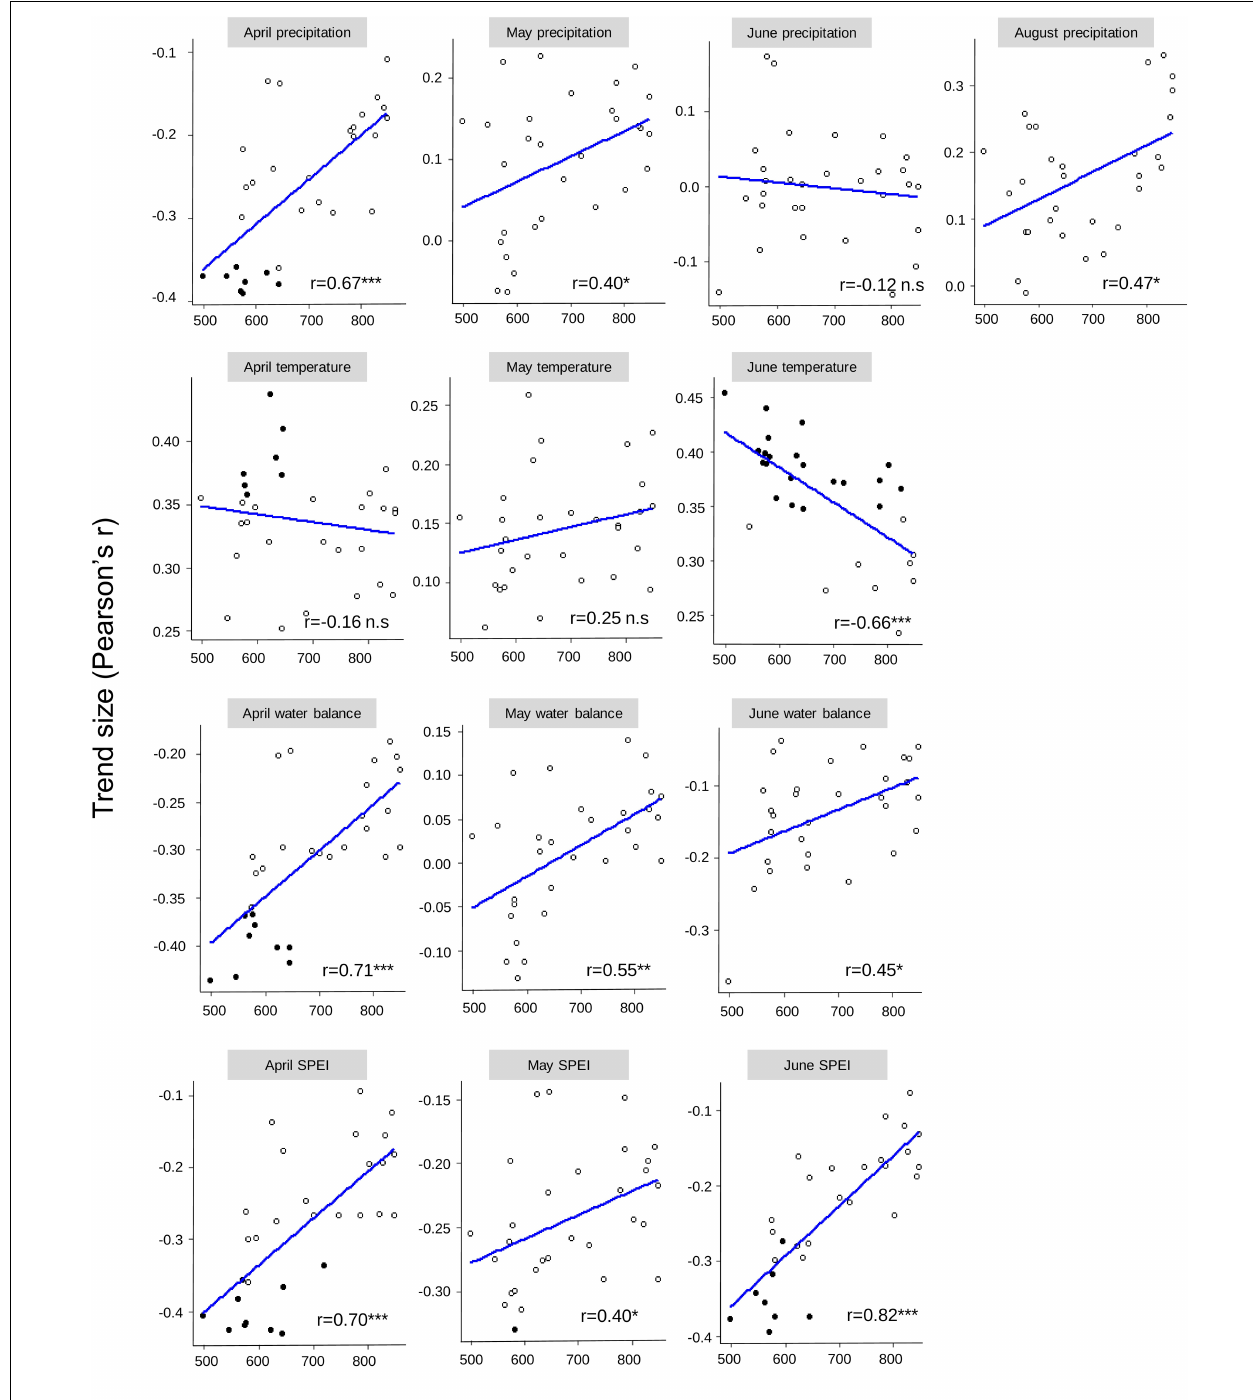
FIGURE 3 | Relationship between the trend size (expressed by Pearson’s r of the correlation of climate variable with calendar year) of long-term change in monthly precipitation, mean temperature, mean climatic water balance and mean SPEI of the months April, May, June, and August in the period 1983–2017 at the 30 sites, and mean annual precipitation at the site. Significance levels of the spatiotemporal relationships: * p < 0.05, ** p < 0.01, *** p < 0.001. For the trend sizes at any of the N = 30 sites (dots), negative r -values along the y -axis represent a decreasing trend, positive r -values an increasing trend. Filled dots: sites with significant trend in the period 1983–2017, circles: sites without significant trend. Results for July, (August), and September are not shown for clarity.